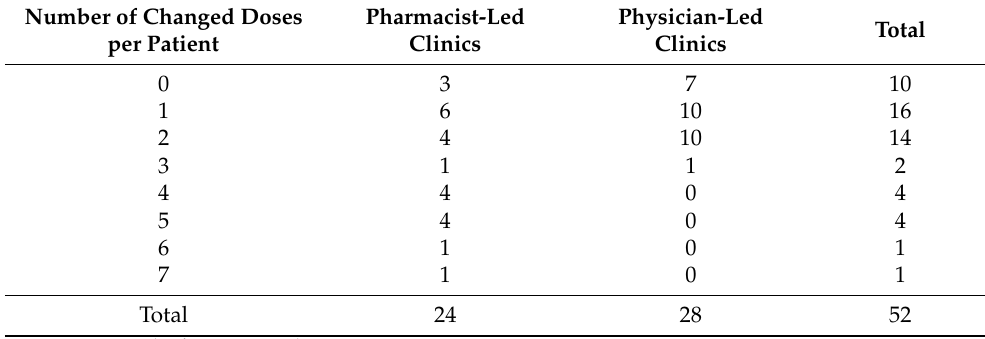
Table 4. Changes in diabetic medication doses.